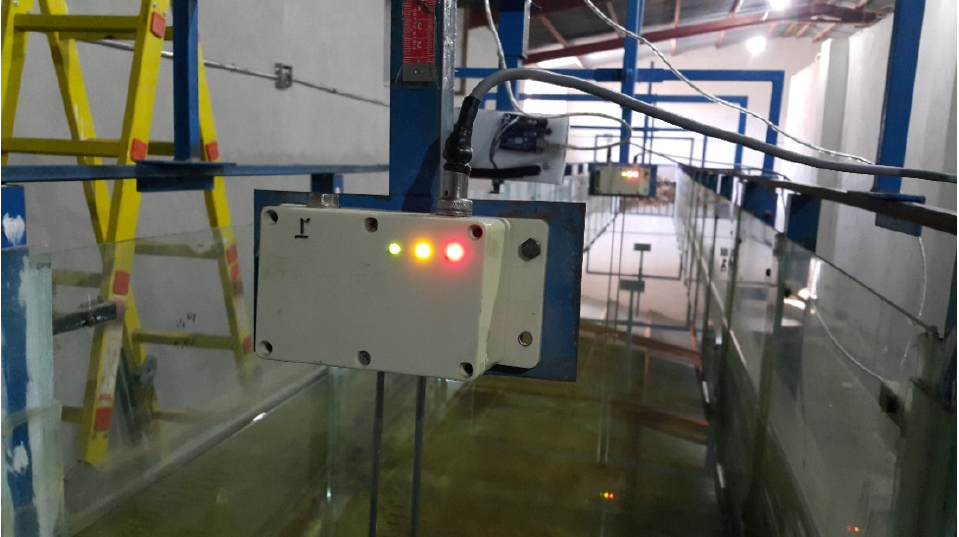
Figure 5. The wave probe instrument.